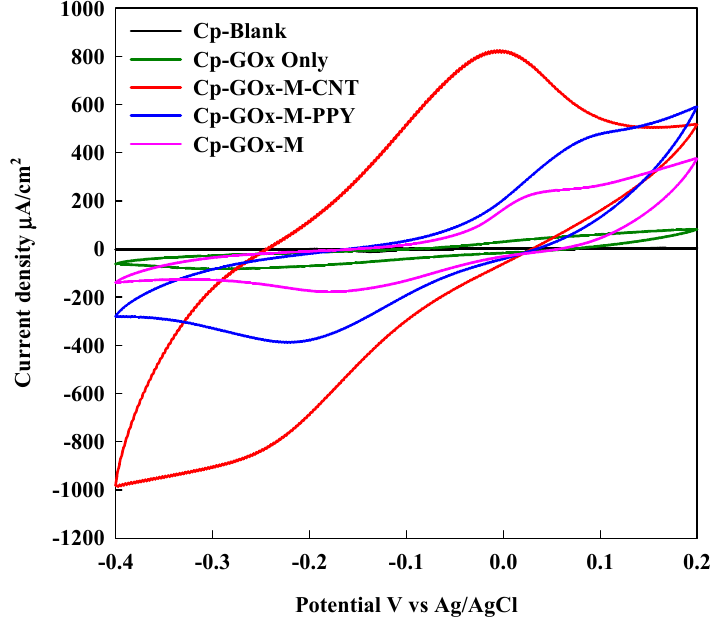
Figure 6. Voltammograms of hydrophilic bioanode electrodes under 0.1 M PBS, pH 7, 37 °C, and N 2 saturation.